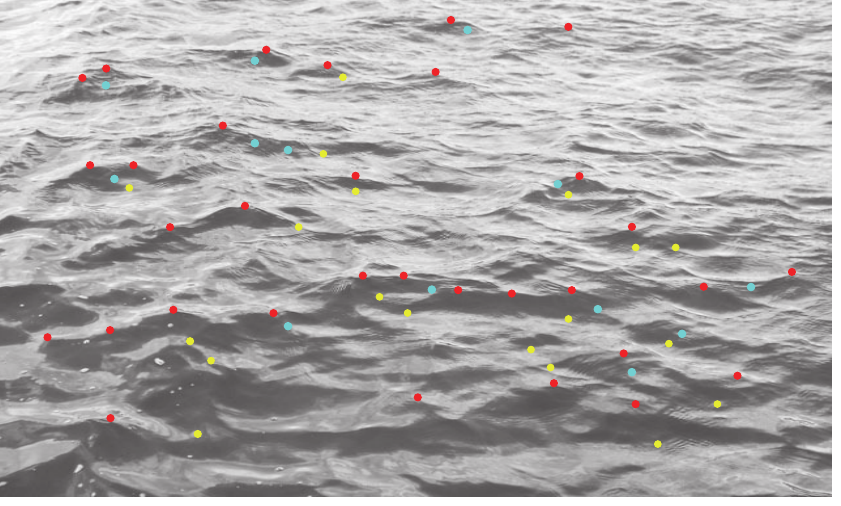
Figure 12. Feature points’ positions. Red, blue and yellow dots represent top, middle and bottom feature points of sea